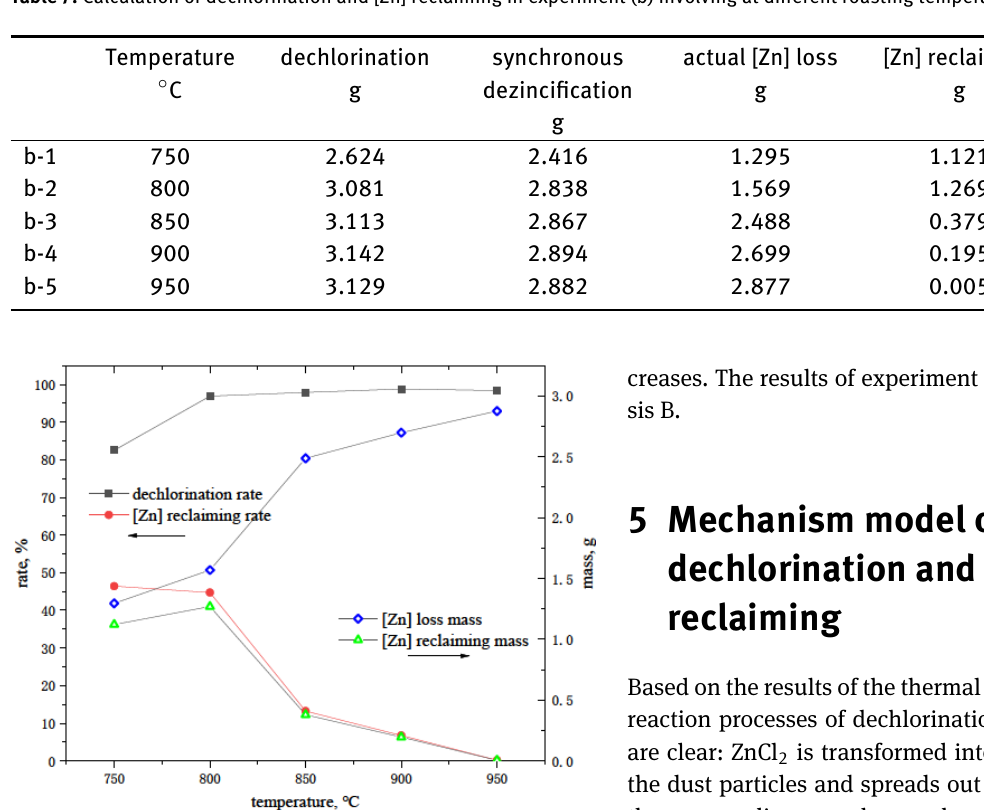
Table 7: Calculation of dechlorination and [Zn] reclaiming in experiment (b) involving at different roasting temperatures